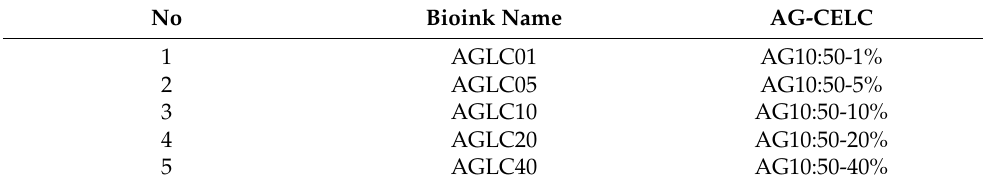
Table 2. The proposed concentrations of AG10:50-CELC to form AGLC